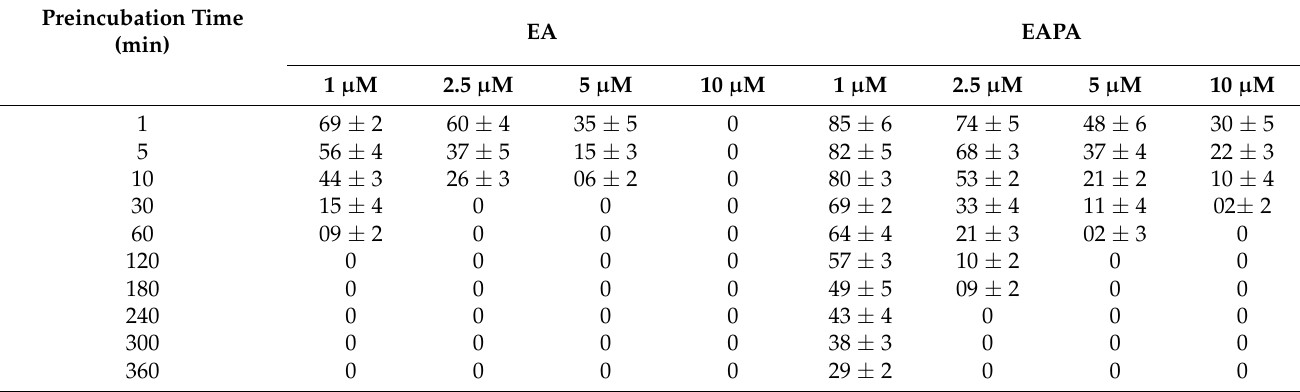
Table 2. Kinetics of decay of the galvinoxyl EPR signal remaining after incubation of 10 µM glavinoxyl with EA and EAPA a .